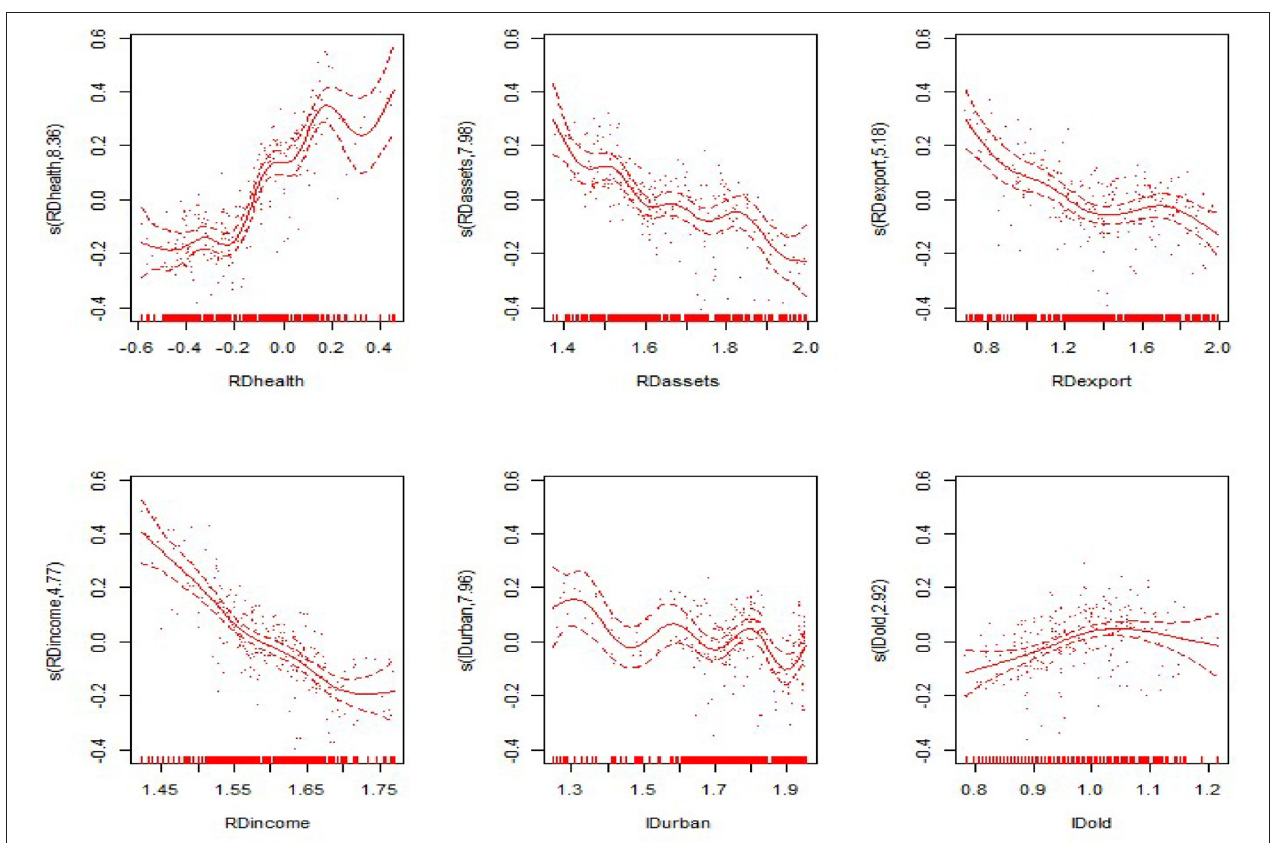
FIGURE 4 | Non-linear effects of the explanatory variables on per capita GDP in the eastern